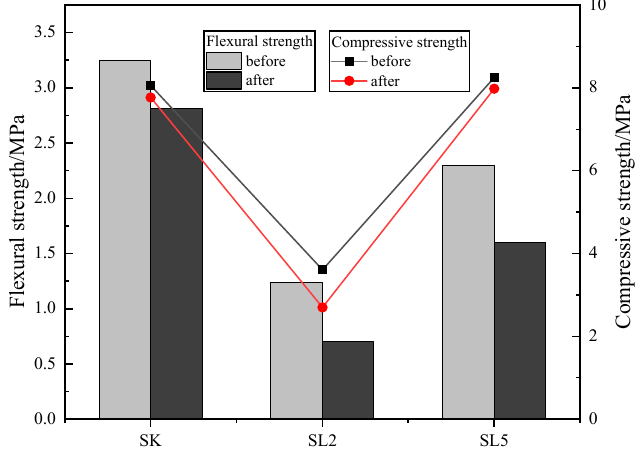
Figure 14. Strength comparison in temperature and humidity cycle.